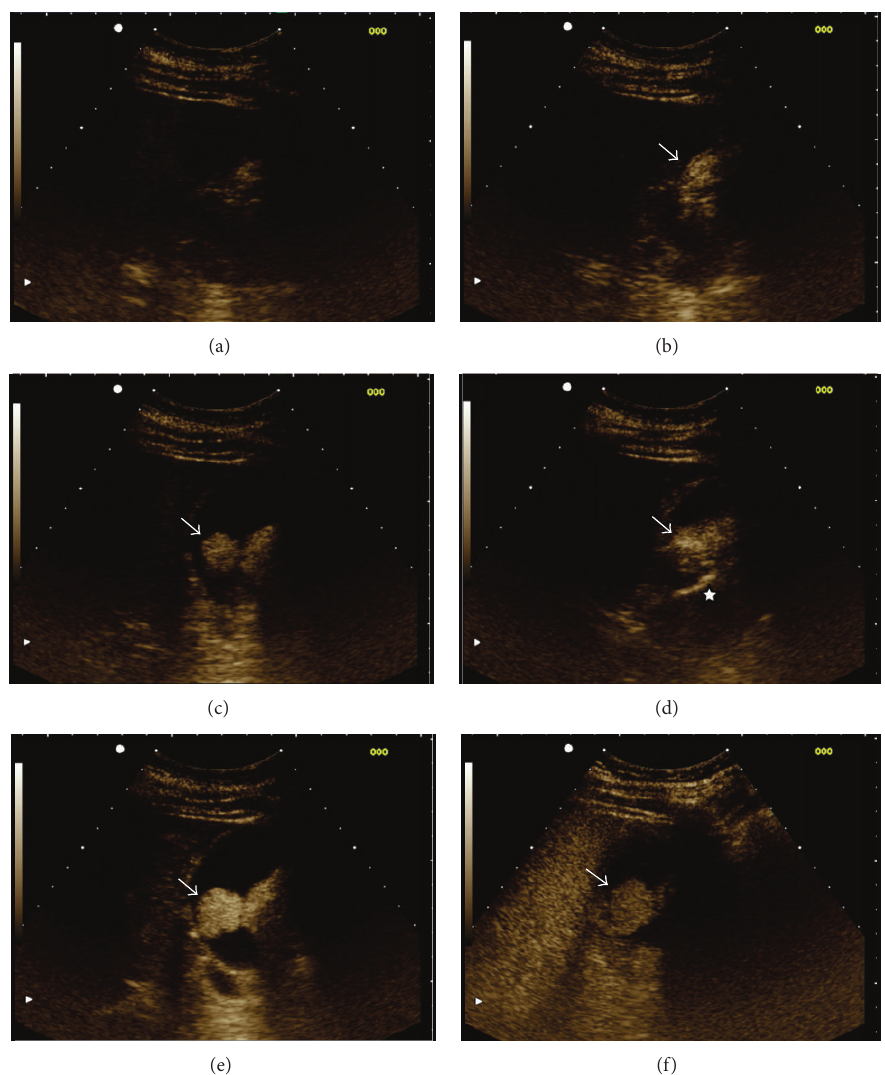
Figure 2: Contrast enhanced ultrasound (CEUS) of the gallbladder at various timepoints of contrast injection: (a) 0sec (baseline); (b) 15sec; (c) 23 sec; (d) 26sec; (e) 35 sec; (f) 120sec. The ultrasound monitor was set to sepia color mode for better contrast visualization. The lobulated gallbladder lesion shows intense and prolonged contrast enhancement (arrow). A feeding arterial vessel is shown in (d) (asterisk). See Supplementary Video